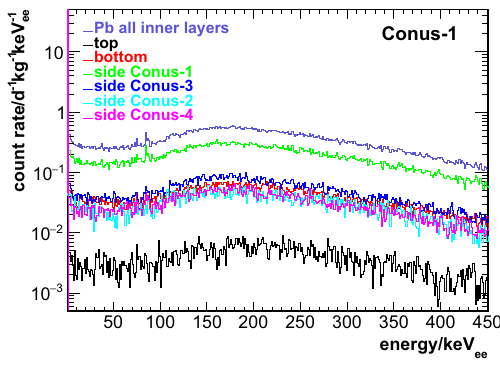
Fig. 14 Comparison of the MC of 210 Pb decays within the cryostat to the data of C1 RUN-1. For the other detectors, this contribution is smaller. It becomes evident that the 46.5keV line in the data is induced by these decays